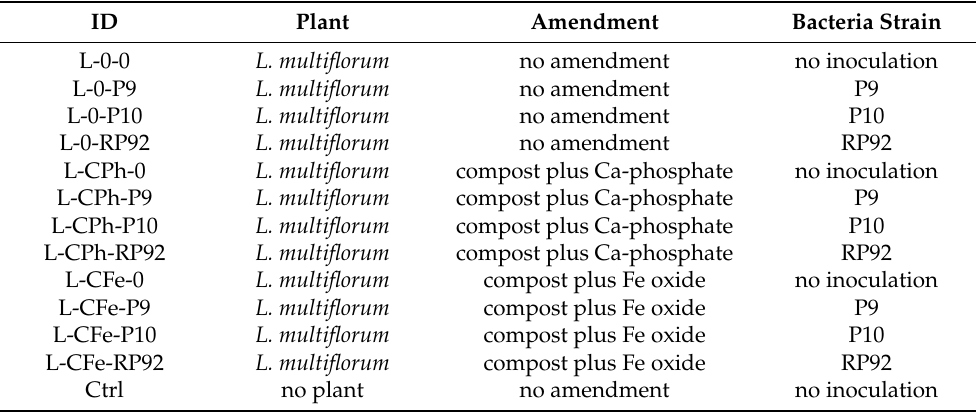
Table 1. Experimental scheme of the greenhouse